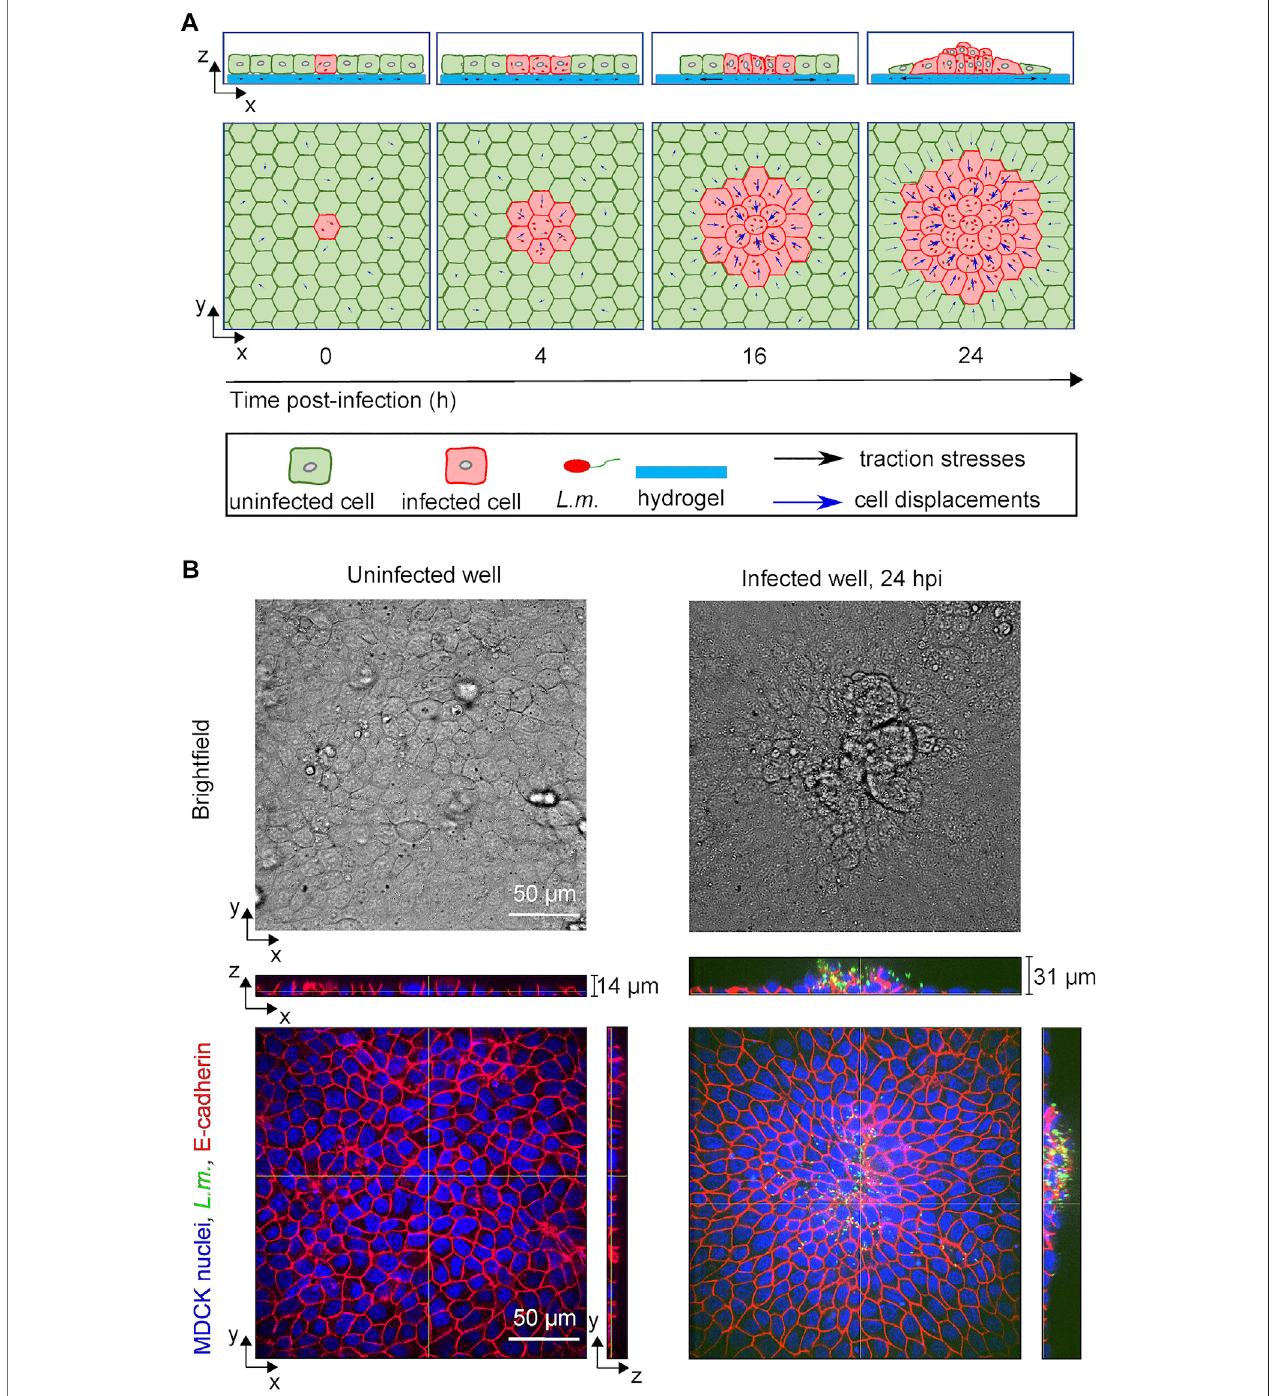
FIGURE1| L.m. -infectedepithelialcellsinmonolayergetcollectivelyextrudedatlateinfection. (A) Schematicillustrationshowingthetimecourseof invitro infection of host epithelial cells with L.m. so that infection mounds emerge at late infection (24 hpi). Initially a single cell gets infected by L.m. (0 hpi), but astimeproceeds bacteria replicate and spread to neighboring cells (4 hpi). Uninfected surrounder cells (green) start actively migrating towards the infection focus comprised by several infected cells (red), while softer and less contractile infected cells get squeezed (16 hpi) and eventually extruded (24 hpi) out of the cellular monolayer. (B) Representative bright fi eld image (top row) and orthogonal views (bottom row) of L.m. fl uorescence in green, E-cadherin in red and MDCK nuclei in blue for cells originating from an uninfected well (left column) and from a L.m. -infected well with the fi eld of view shown focused around and infection focus at 24 hpi (right column).